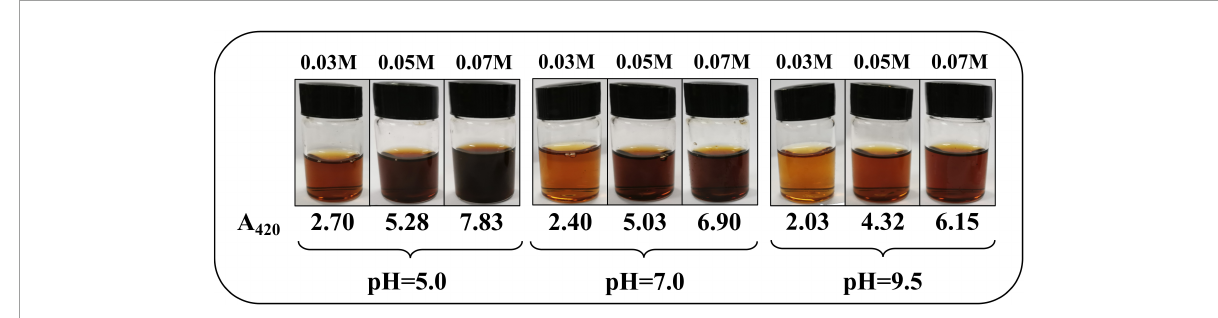
FIGURE1 The color of the reaction solution at different concentrations of L -ascorbic acid (ASA) and pH values, at 190 ◦ C, 90 min.